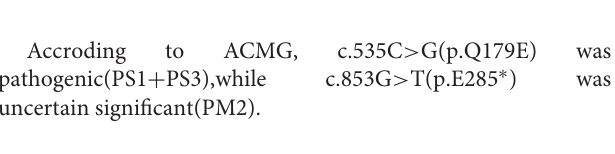
FIGURE 4 | Distribution of eight IFT74 gene mutations (transcript: